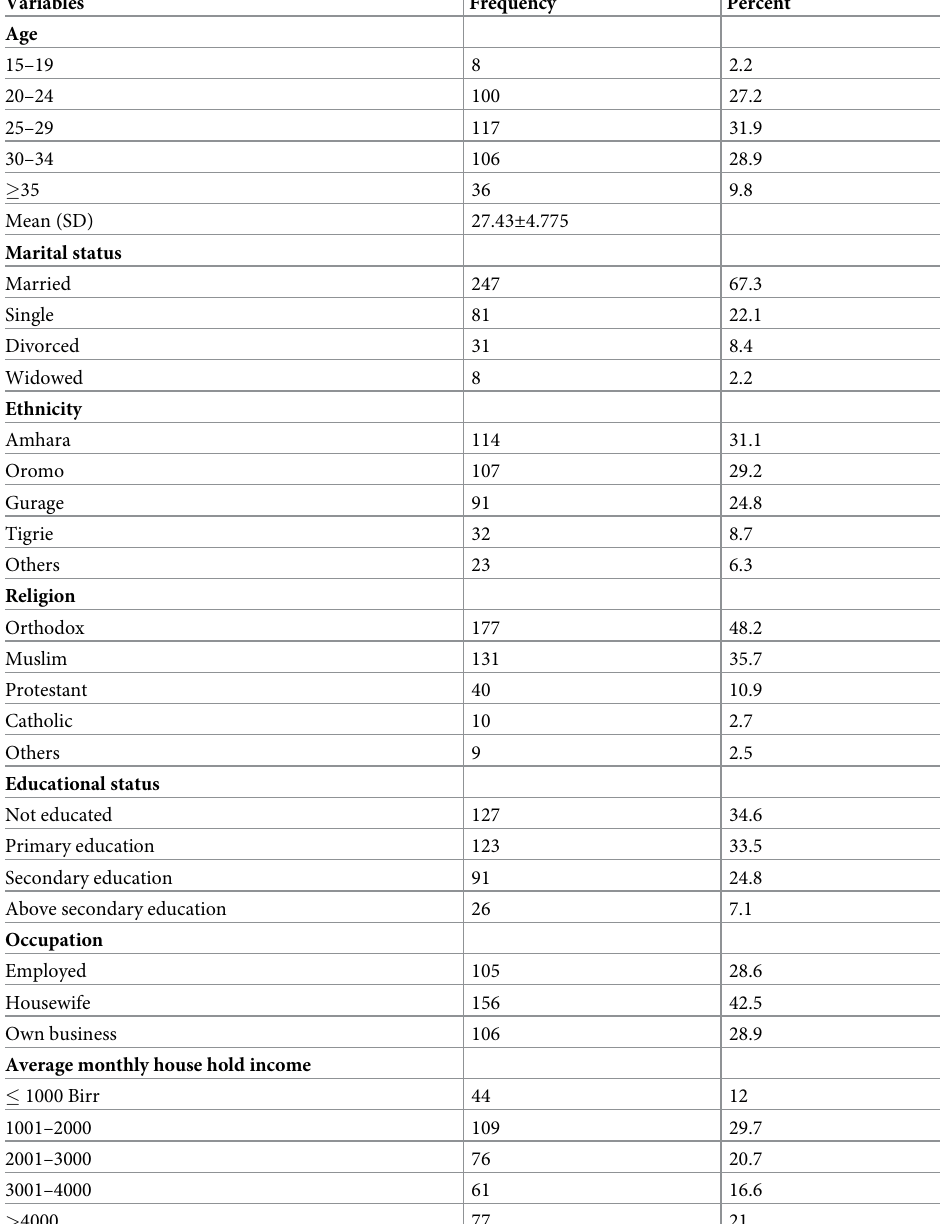
Table 1. Socio-demographic characteristics of pregnant women in Kolfe Keranio sub city (n = 367), Addis Ababa, Ethiopia.